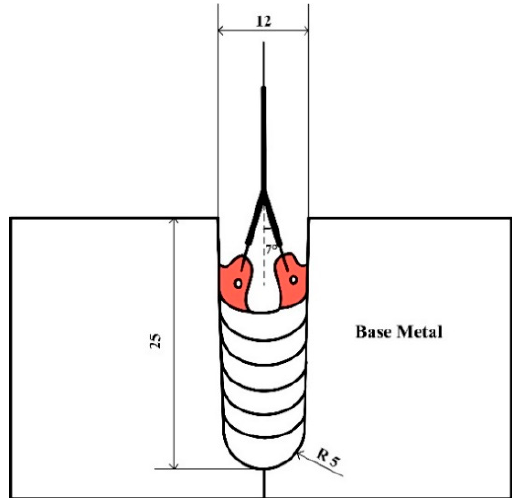
Figure 2. Geometrical size of the groove. Table 1. Welding parameters.